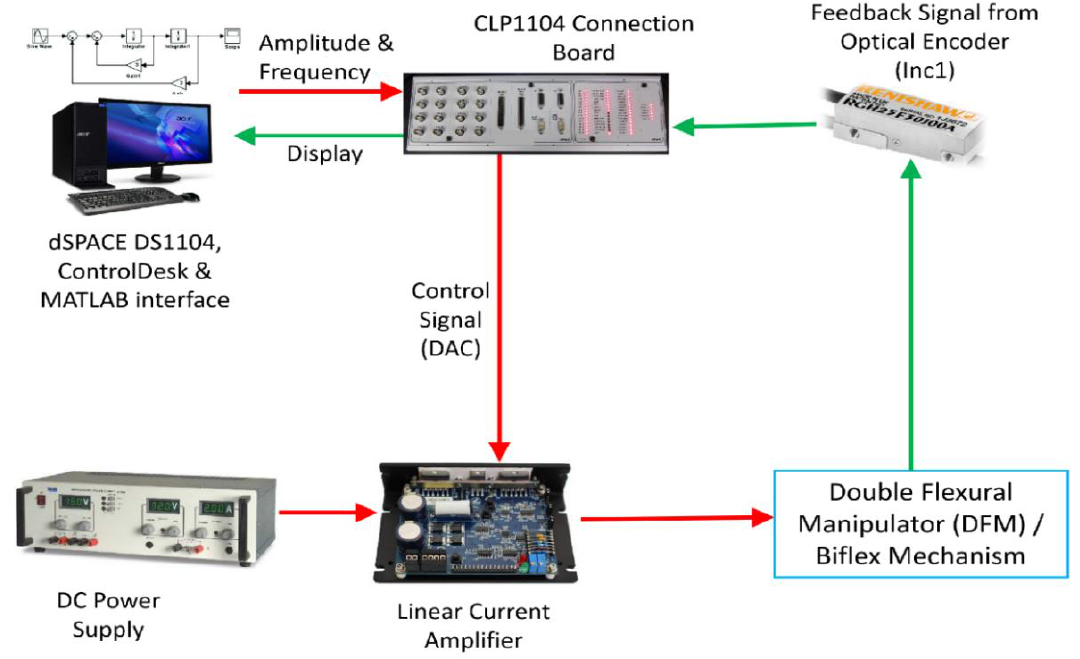
Figure 11. Mechatronic integration for the biflex mechanism.